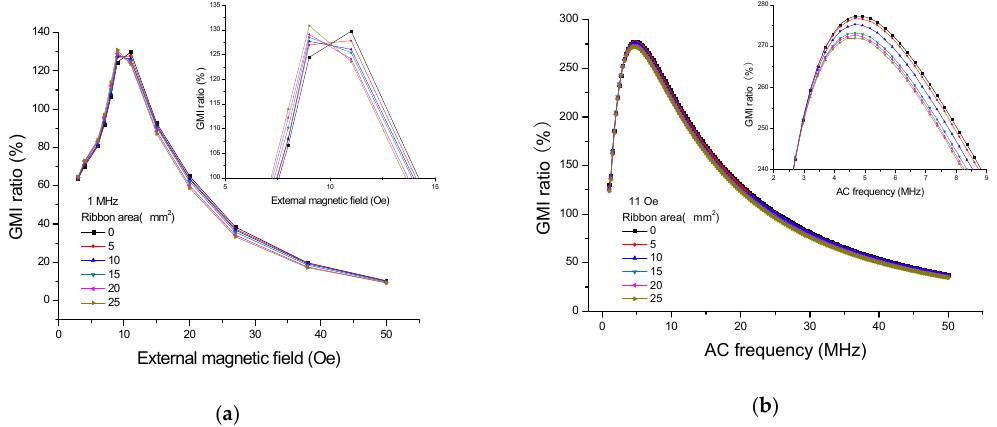
Figure 6. The giant magnetoimpedance responses when the ribbons are tested in front of the giant magnetoimpedance sensor I: ( a ) field dependence and ( b ) frequency dependence.